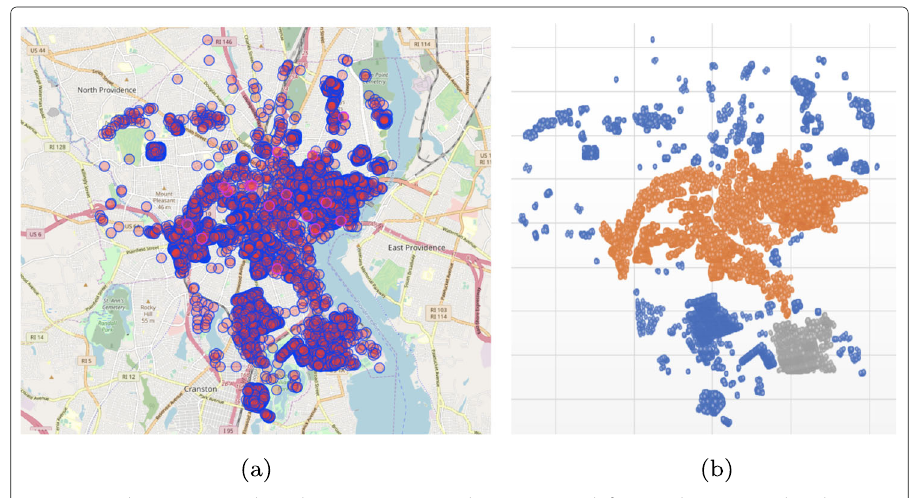
Fig. 2 Providence Query and Resulting Geometric Graph. a Query Result for Providence as Displayed in Overpass Turbo. b Providence Network Generated from Longitude and Latitude